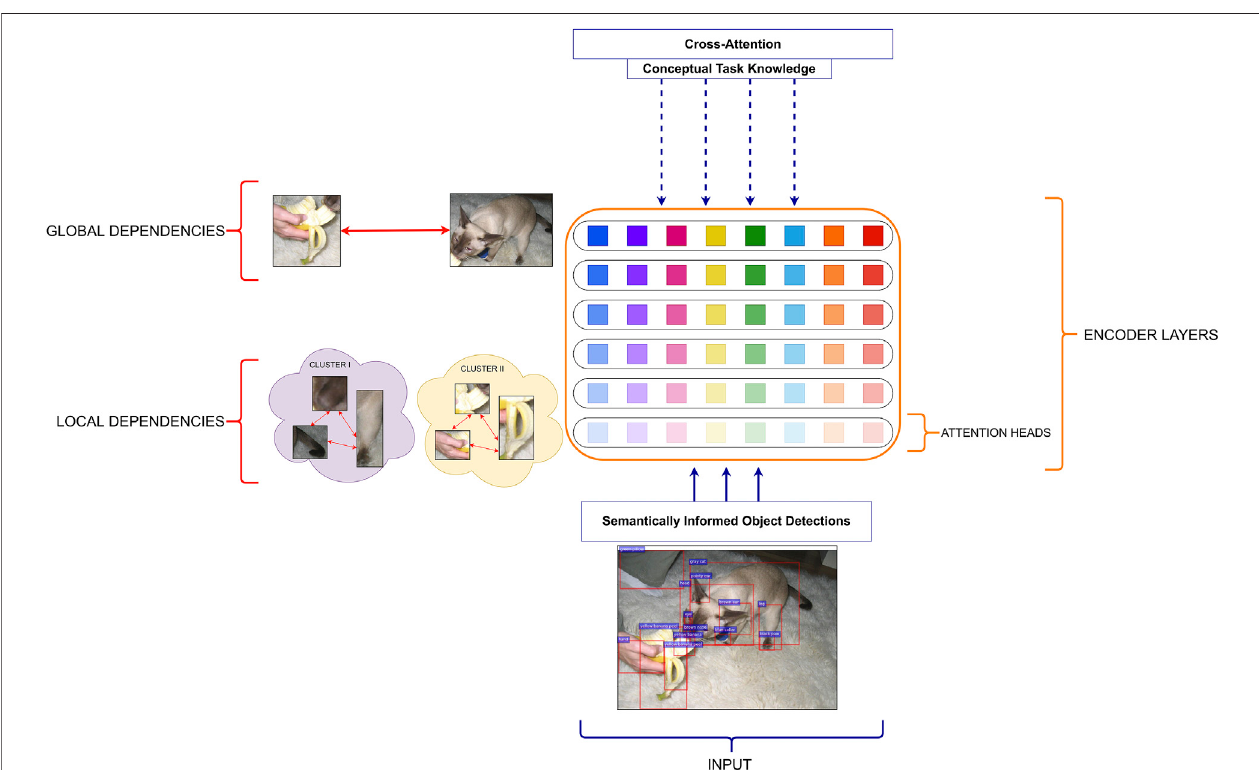
FIGURE 13 | A visual conceptualisation of the most important fi ndings of the current study. The colour intensity of each attention head increases with layer depth, resembling the increase in attention strength. Left: as shown, earlier layers capture more local dependencies between thematically related objects, while deeper layers connect distant objects. Below: the input to the model is the set of semantically informed features of detected objects, which is in contrast to the grid-based approach, whereimagepatchescarrynosemantics.Above: wealsodenoteanindirectin fl uence(dottedlines)fromthecross-attentionmodule,whichpossiblyoccursdueto backpropagation and is re fl ected in the heavier grounding of noun phrases in deeper heads that we examine in Section 3.4 . Overall, this fi gure demonstrates the whole variety of fi ndings that we present in this